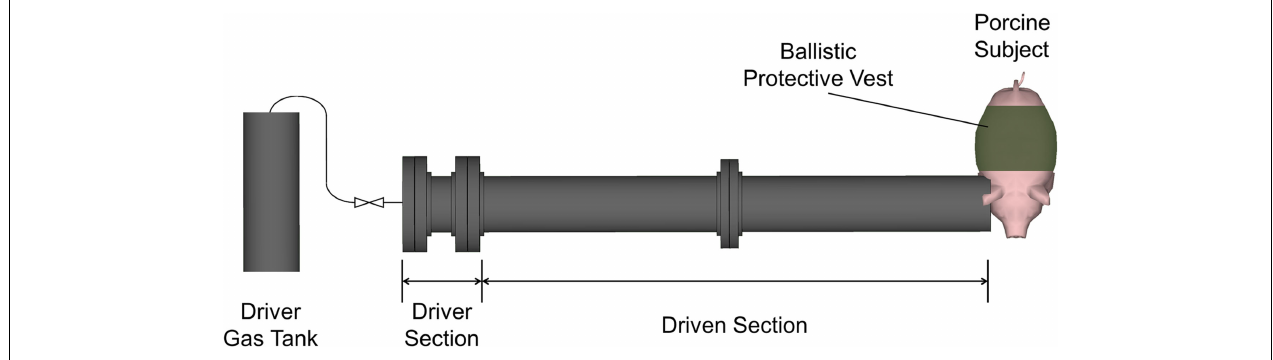
FIGURE 1 | Shock tube and test setup schematic.